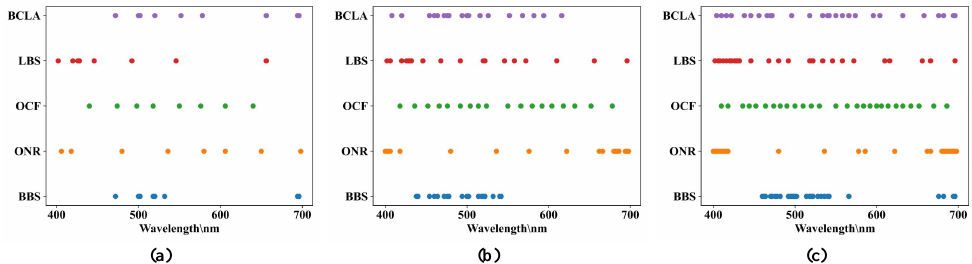
Figure 10. The band selection result with different selected band amounts for the compared band selection methods on the turbid water data set. ( a ) 8 bands, ( b ) 18 bands, ( c ) 27